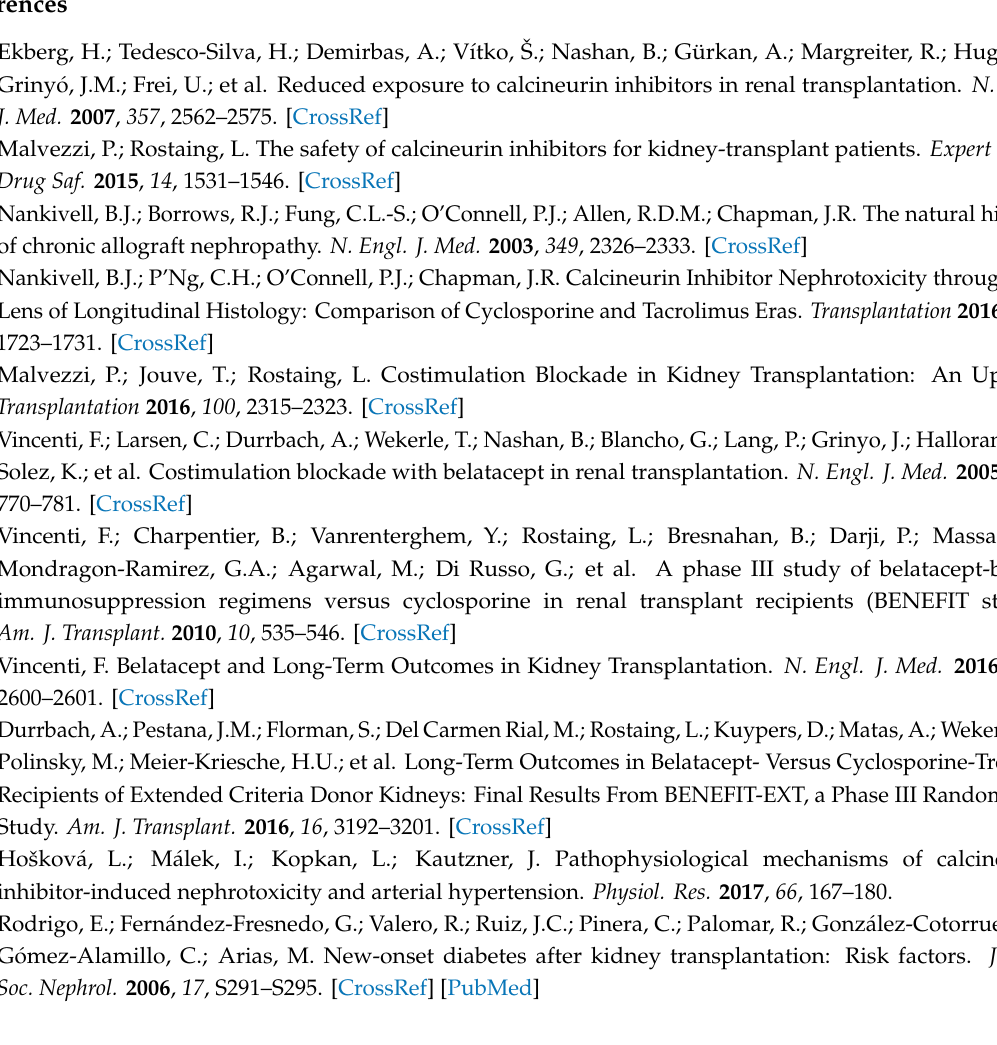
Table S1: Comparison of data of patients from initial cohort (from Bertrand et al.) and pooled monocentric cohort, Table S2: OPI description in patients who developed two OPI during the